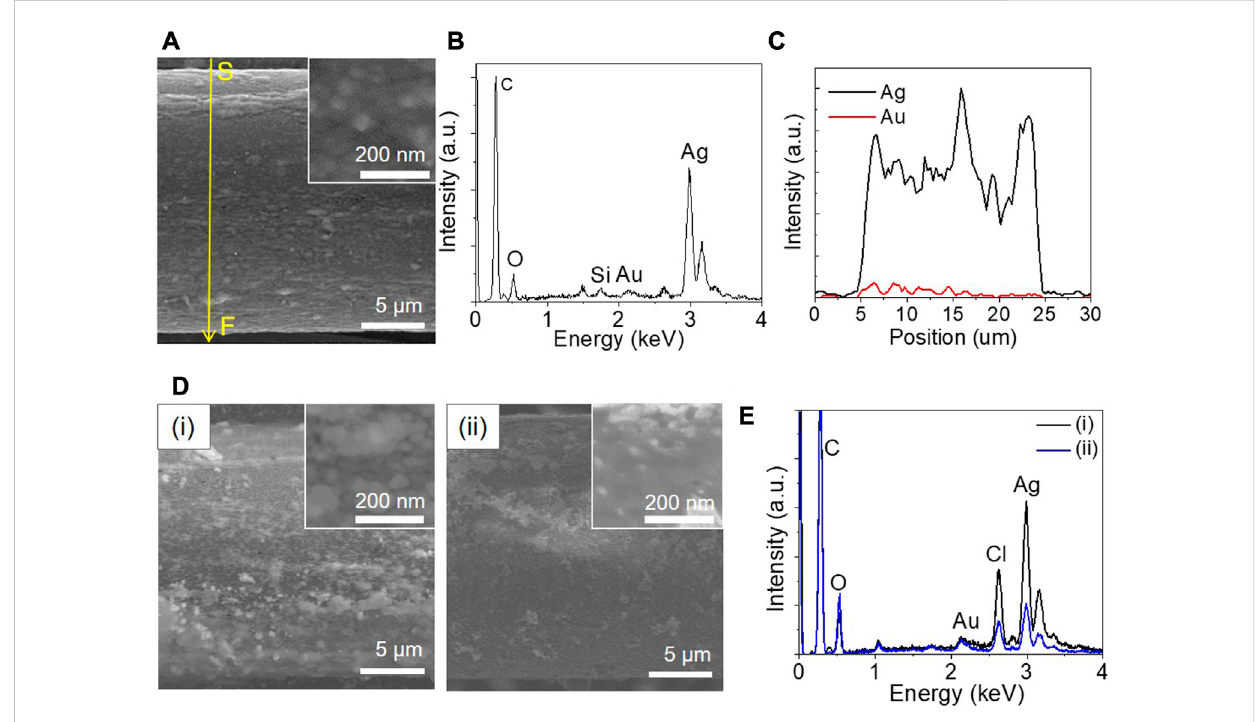
FIGURE 5 (A) SEM image of a partly gold-coated strand (the inset indicates the enlarged top view images of the gold surface). (B) EDS spectra and (C) compositionalvariationofsilverandgoldelementsalongthescanlinefromStoFindicatedbytheyellowarrowin (A) . (D) SEMimagesand (E) EDSspectra of the partly gold-coated strand after the immersion time in 1 M NaCl solution at 60 ° C for (i) 35,000 and (ii) 864,000 s, respectively. (The insets indicate the enlarged SEM images of the top view).